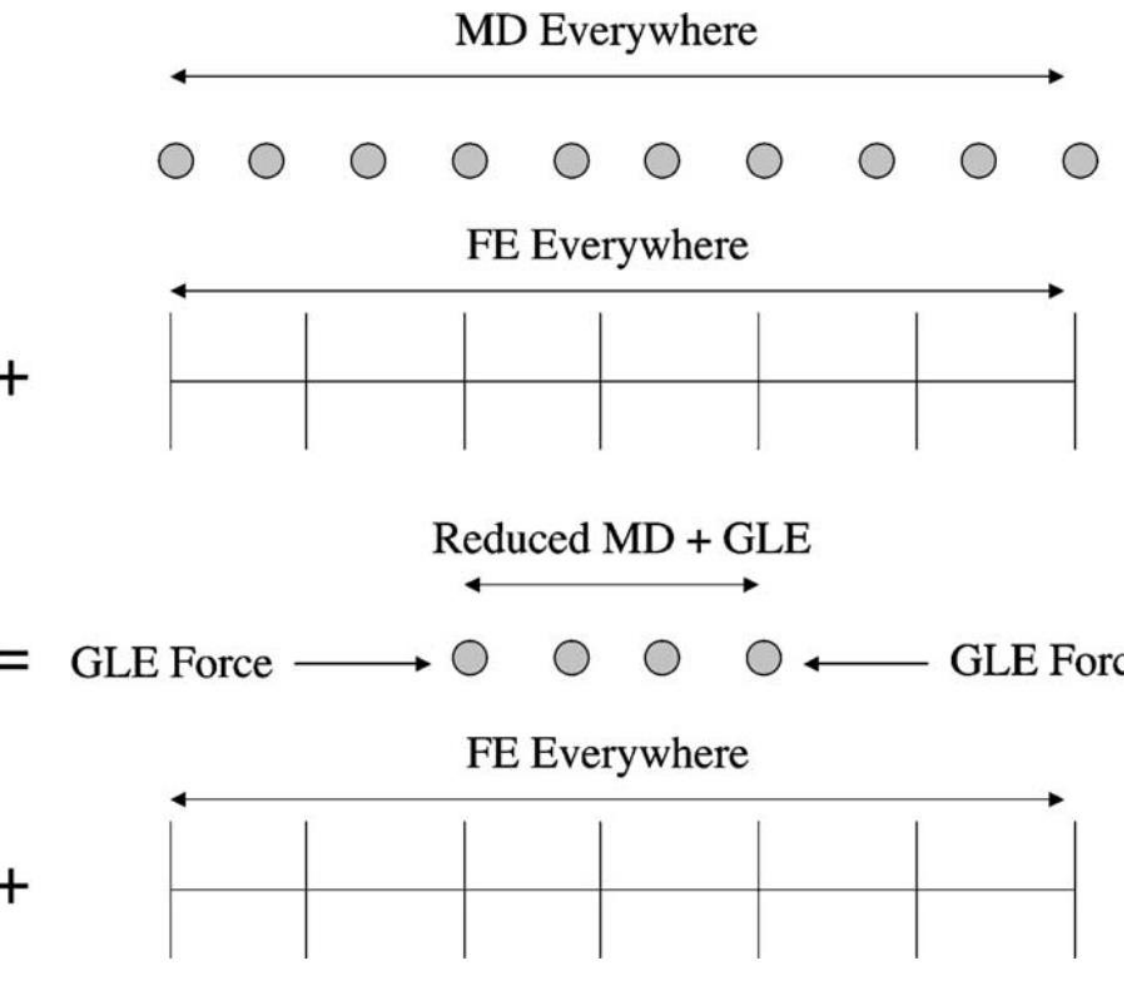
Figure 4. Illustration of schemes where the MD region spans the FE region fully (top) and partially (bottom). Reproduced with permission from [58].